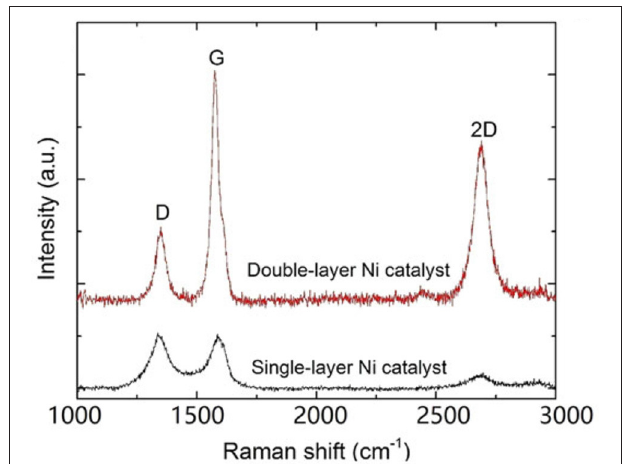
FIGURE 13 | Raman spectra of samples with single- and bilayer catalysts deposited at 3 mJ [Reproduced from Dong et al. (2017) with permission of Springer].